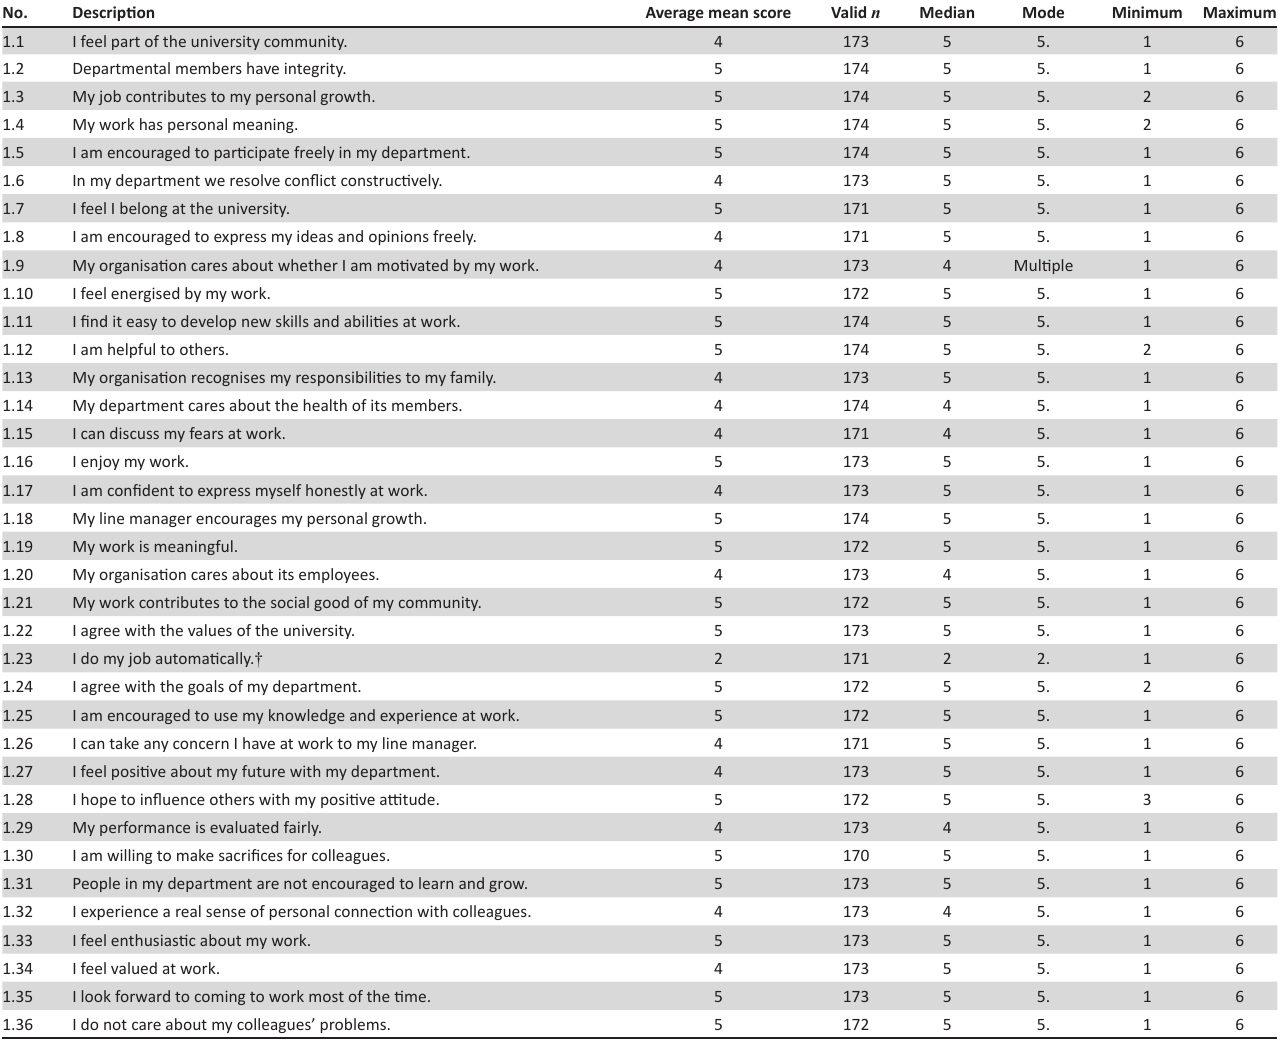
TABLE 1: Descriptive statistics for workplace spirituality. No.